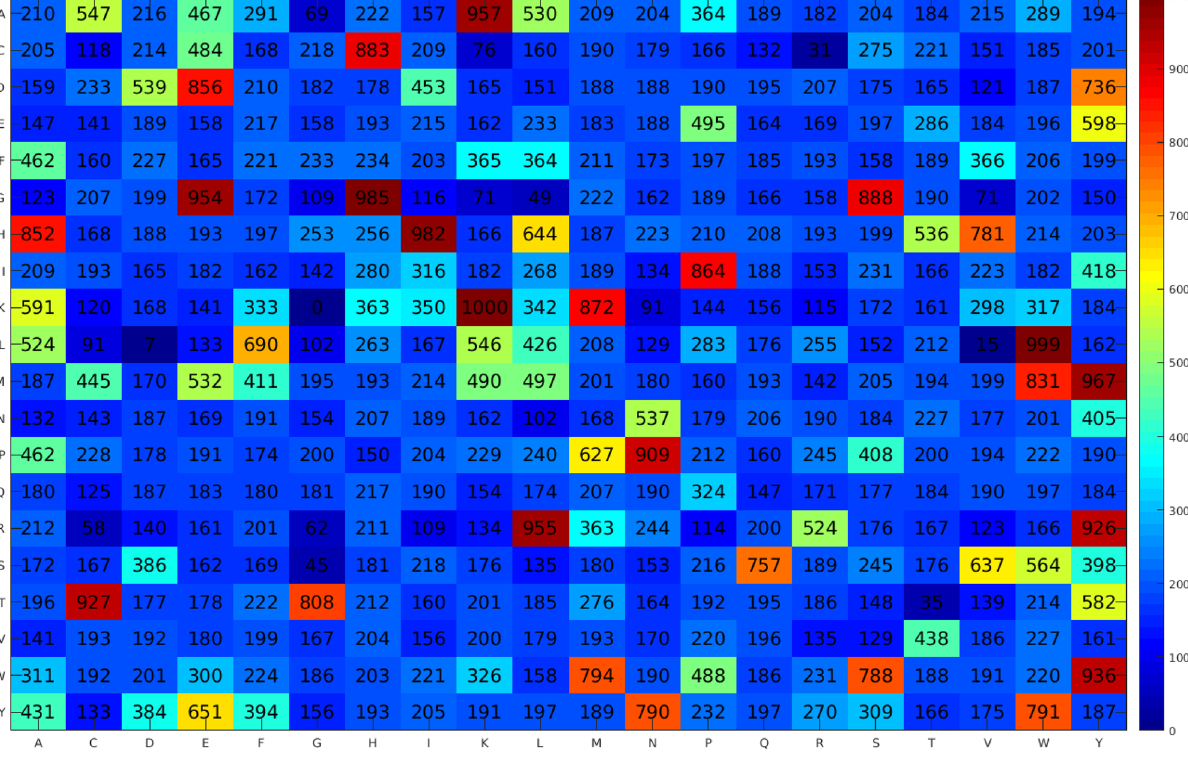
Figure 2. Heatmap of amino acids propensity scores obtained from the proposed